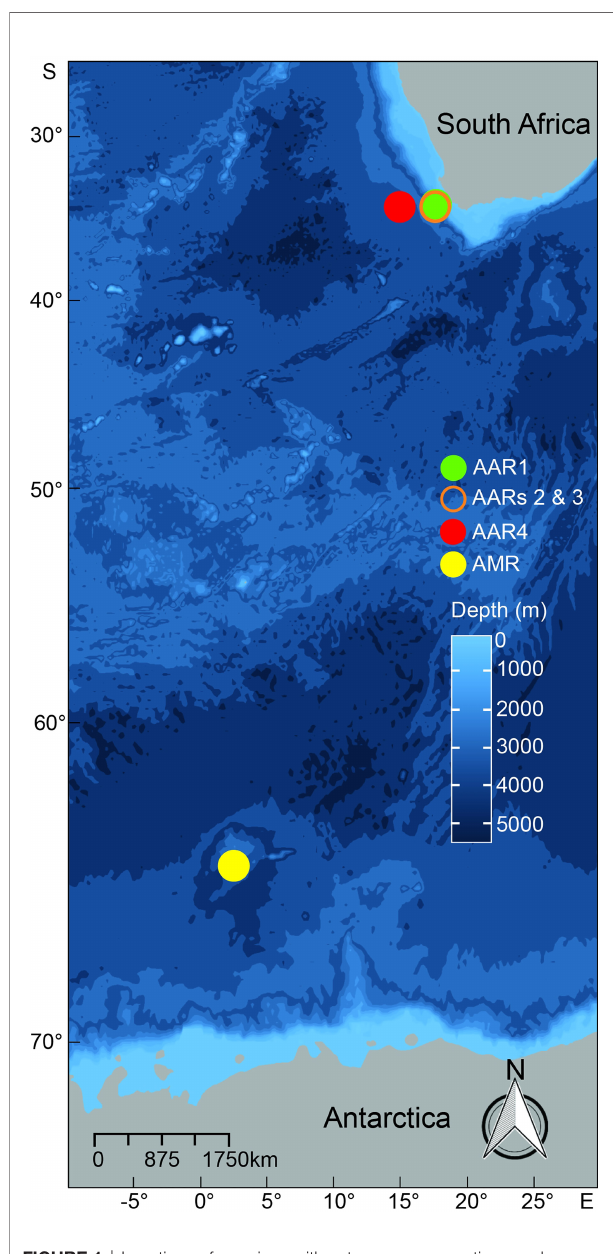
FIGURE 1 | Locations of moorings with autonomous acoustic recorders (AARs) off the west coast of South Africa (AARs 1, 2, 3 and 4) and the Maud Rise, Antarctica (AMR). Shading colour of each circle, as detailed in the key, represents positions of